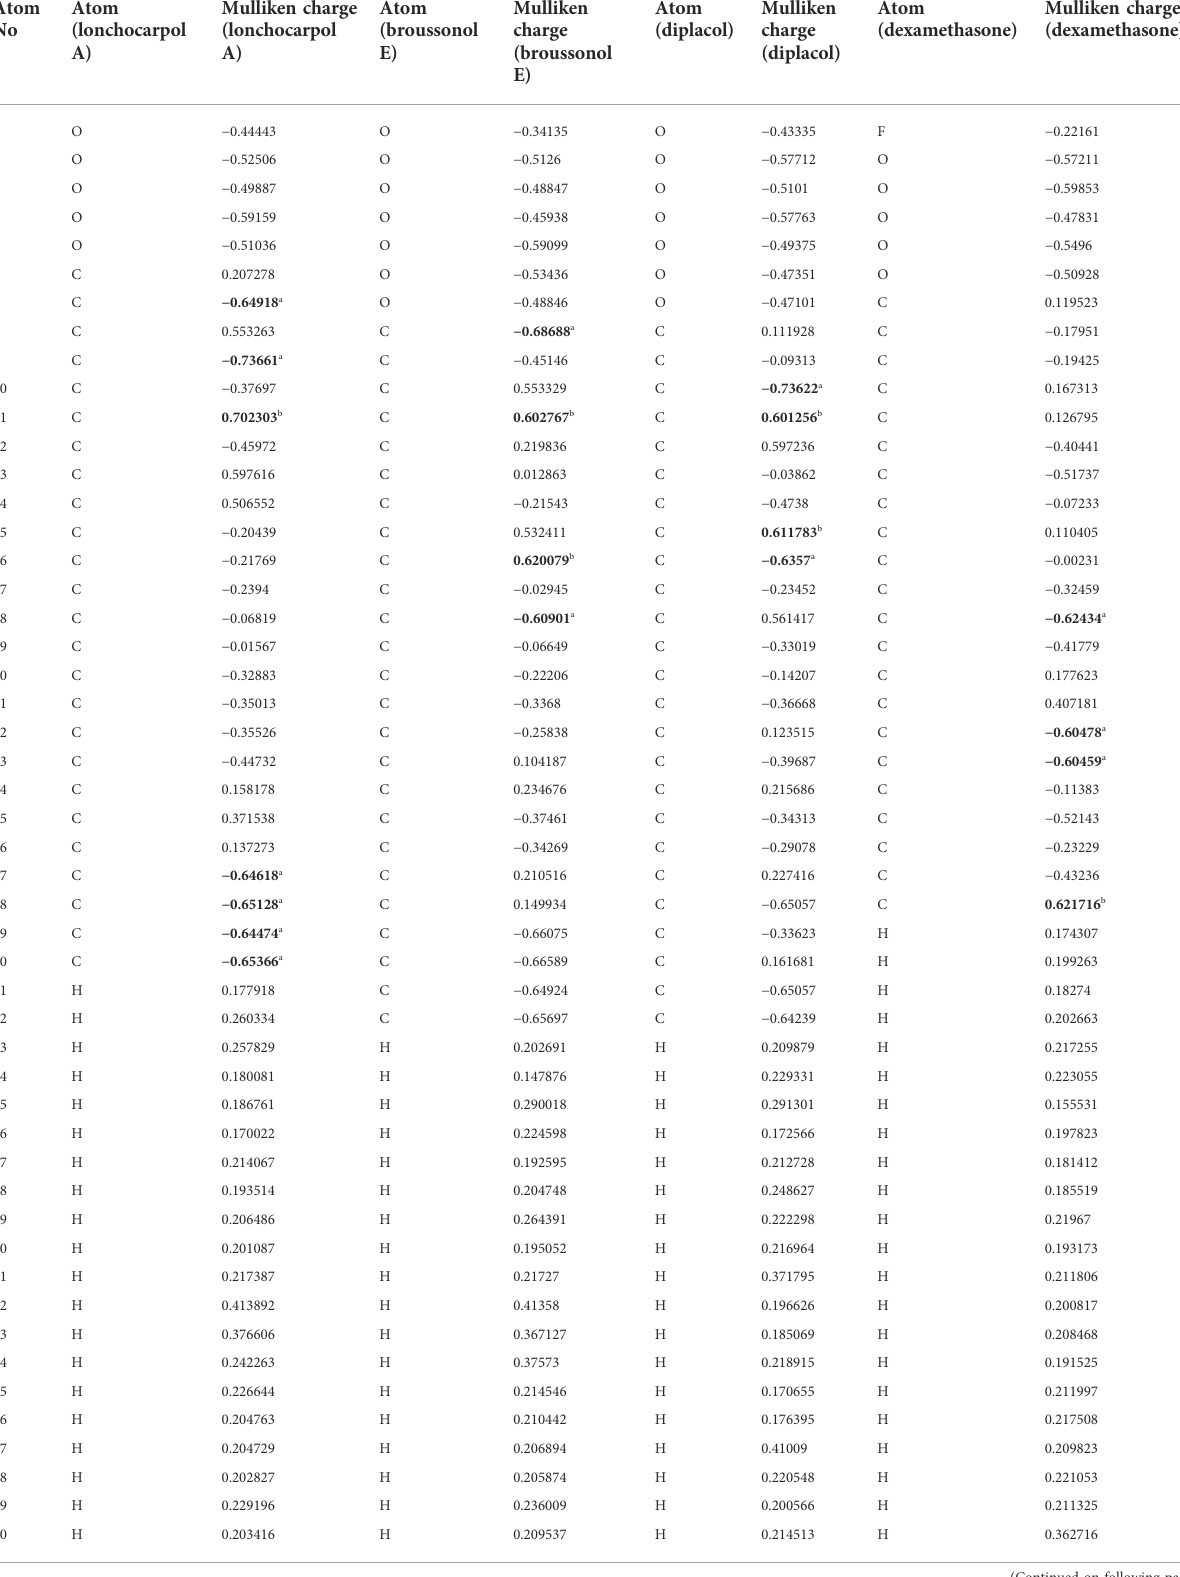
TABLE 2 Calculated Mulliken atomic charges of the top four